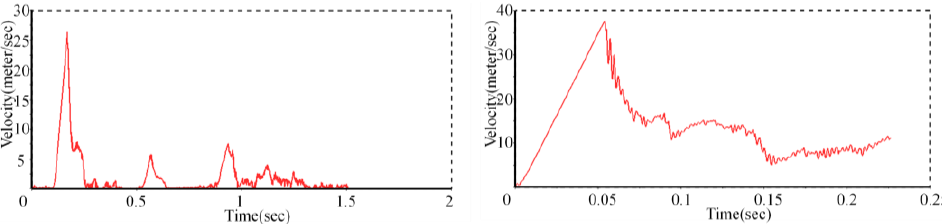
Figure 11. Bending speed of the double-segment pipeline robot and single-segment pipeline robot. The average speed of double-stage PIG cornering is 2.5 m/s, while the average speed of single-stage PIG cornering is 20 m/s. The speed of double-segment PIG cornering is much lower than that of single-segment PIG cornering. According to the force formula of PIG